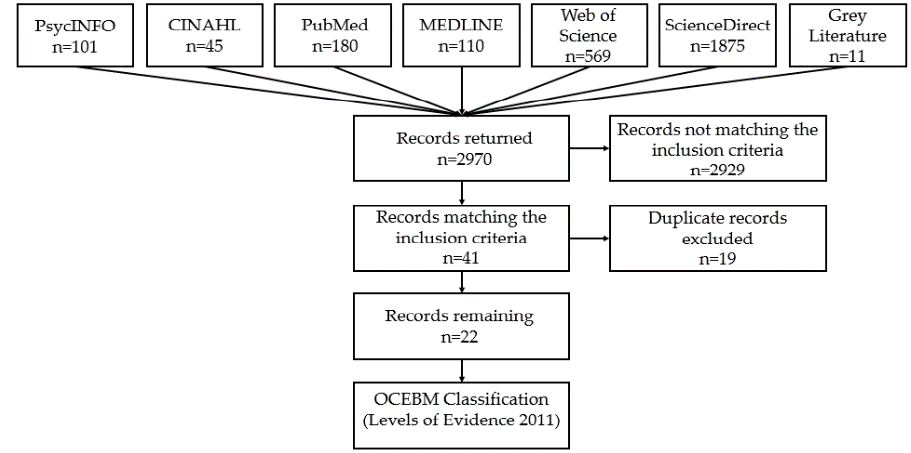
Figure 1. PRISMA (Preferred Reporting Items for Systematic Reviews and Meta-Analyses) flow diagram.